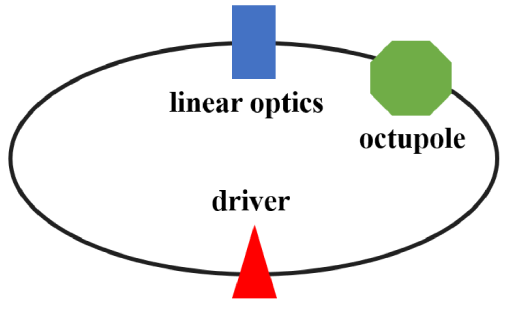
FIG. 1. Schematic of a simple nonlinear storage ring model.